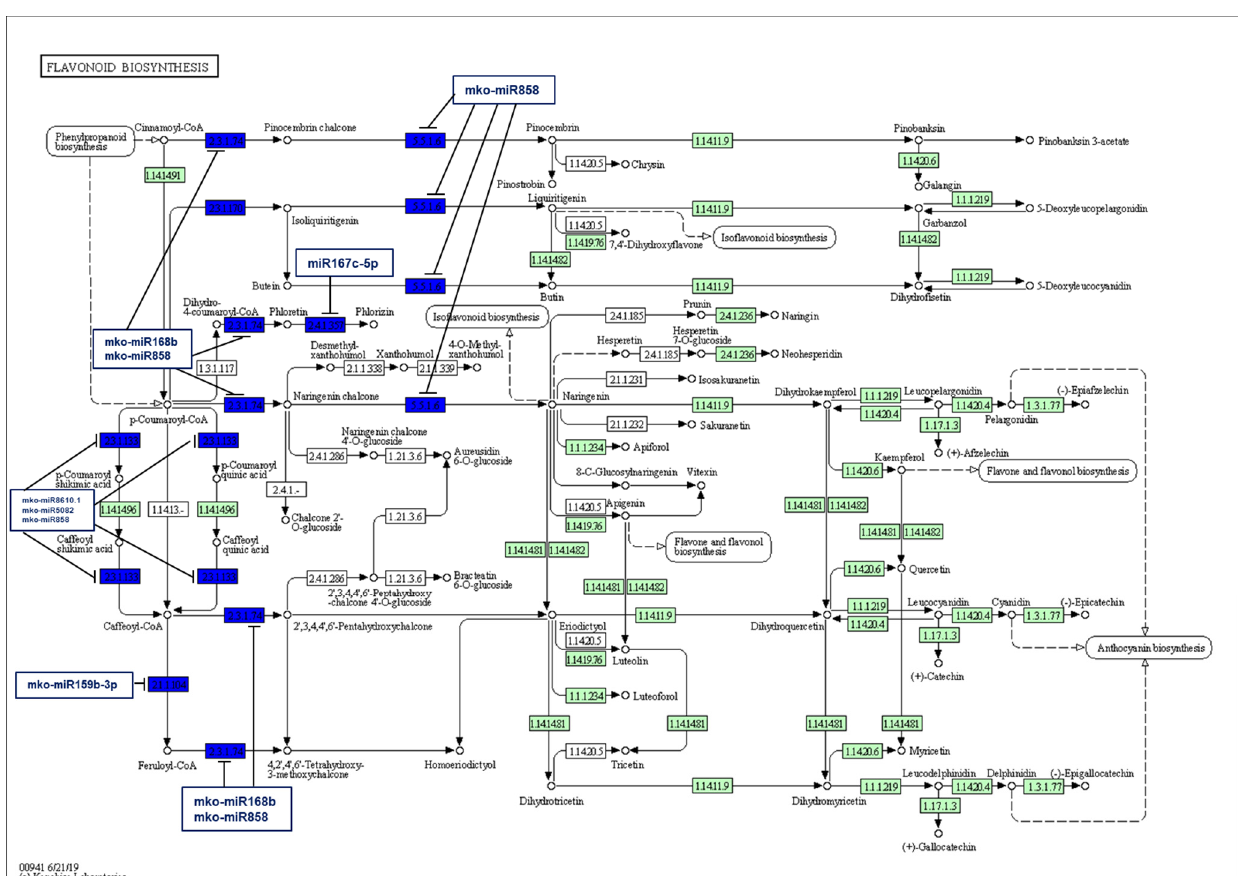
Figure 7. Target enzymes of conserved miRNAs of M. koenigii in the flavonoid biosynthesis pathway. EC:2.3.1.74—chal- cone synthase; EC:5.5.1.6—chalcone isomerase; EC:2.1.1.104—caffeoyl-CoA O-methyltransferase; EC:2.3.1.133—shikimate O-hydroxycinnamoyltransferase; EC:2.4.1.357—phlorizin synthase. The blue boxes represent the targeted enzymes of the corresponding known